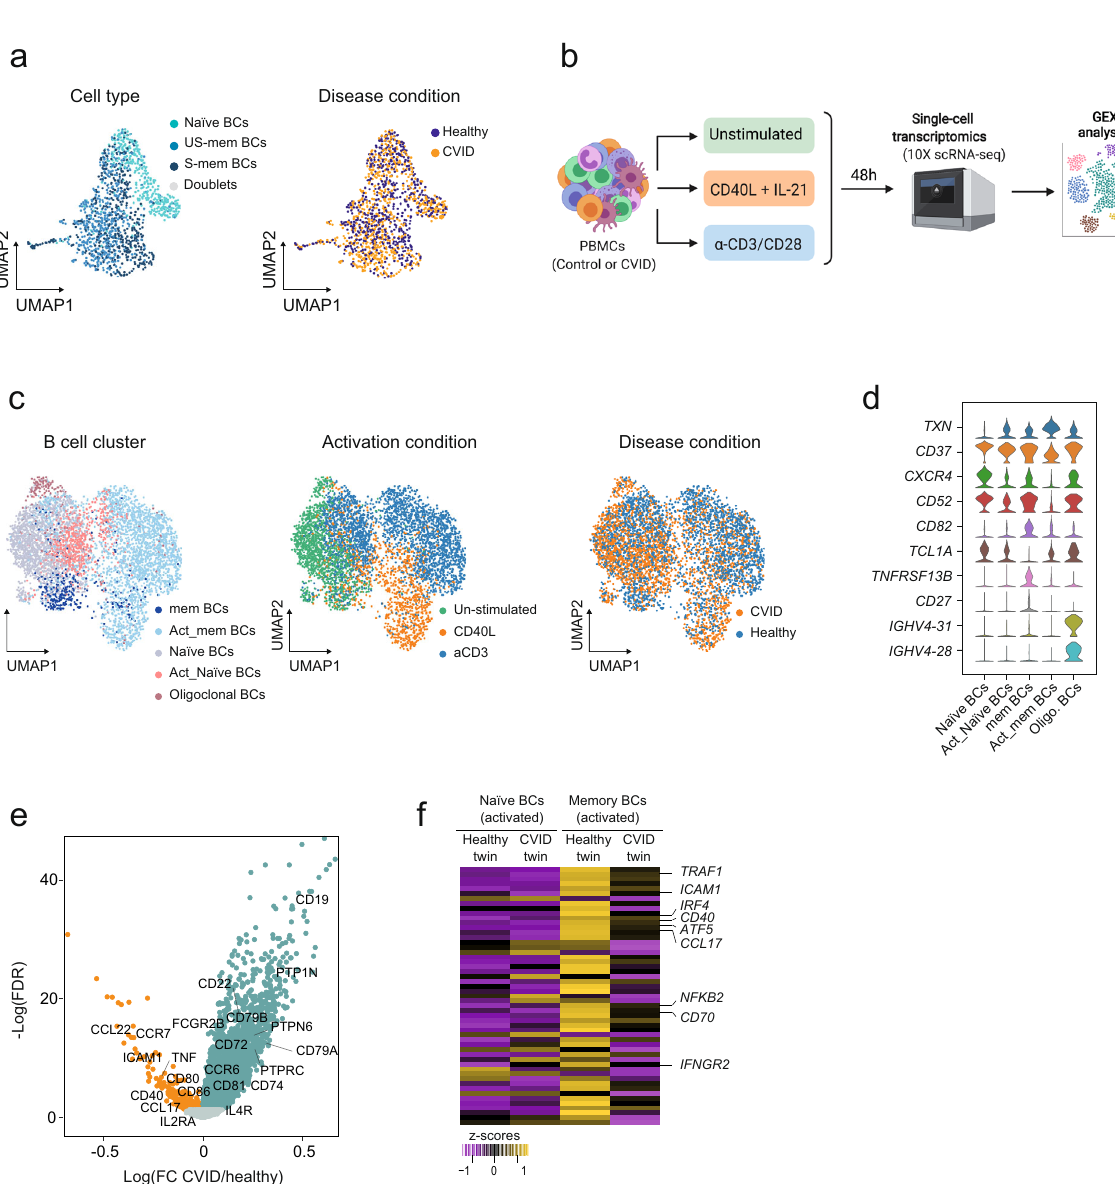
Fig. 4 CVID transcriptional defects in activated B cells. a Unsupervised UMAP visualizations of SS2 single-cell transcriptome data based on highly variable genes and indicating B-cell subset and cell origin (1324 cells). b Scheme depicting immune cell activation with CD40L + IL-21 (B-cell activation) or α -CD3/CD28 (T-cell activation), the establishment of cell – cell communications after cell stimulation and the use of 10× Chromium technology for single- cell transcriptomic analysis. Graph created with BioRender.com. c Unsupervised UMAP visualizations (5119 cells) showing the predicted classi fi cation of B cells into steady state or activated naïve and memory B cells using logistic regression, the stimulation conditions and disease distributions. d Violin plots representing the expression of selected marker genes used to annotate the B-cell subpopulations in the CVID and healthy twins. e Volcano plot representing differentially expressed genes in activated memory B cells comparing control and CVID twins. Some relevant upregulated and downregulated genes are labeled. f Heatmap representing the expression levels of selected dysregulated genes in CVID activated memory B cells corresponding to the nearest gene to a CVID.no-demeth DMR. Activated naïve B cells and activated memory B cells from CVID-discordant twins are represented. Source data for panels in this fi gure are provided in the Source Data Fig. 4 fi additional to B cells from the CVID-discordant twin pair. Clus- tering and cell type-speci fi c marker gene expression allowed us to identify several populations of immune cells: B cells (including naïve and memory B cells), CD4 + and CD8 + T cells (naïve and memory), CD8 + MAIT cells, Treg cells, γδ -T cells, two subsets of NK cells, myeloid cells and their corresponding activated subsets (Fig. 5a, b and Supplementary Fig. 6a). Differential gene expres- sion analysis between the two CVID-discordant siblings within each compartment revealed transcriptional dysregulation in immune subsets other than B cells (Supplementary Data 8).